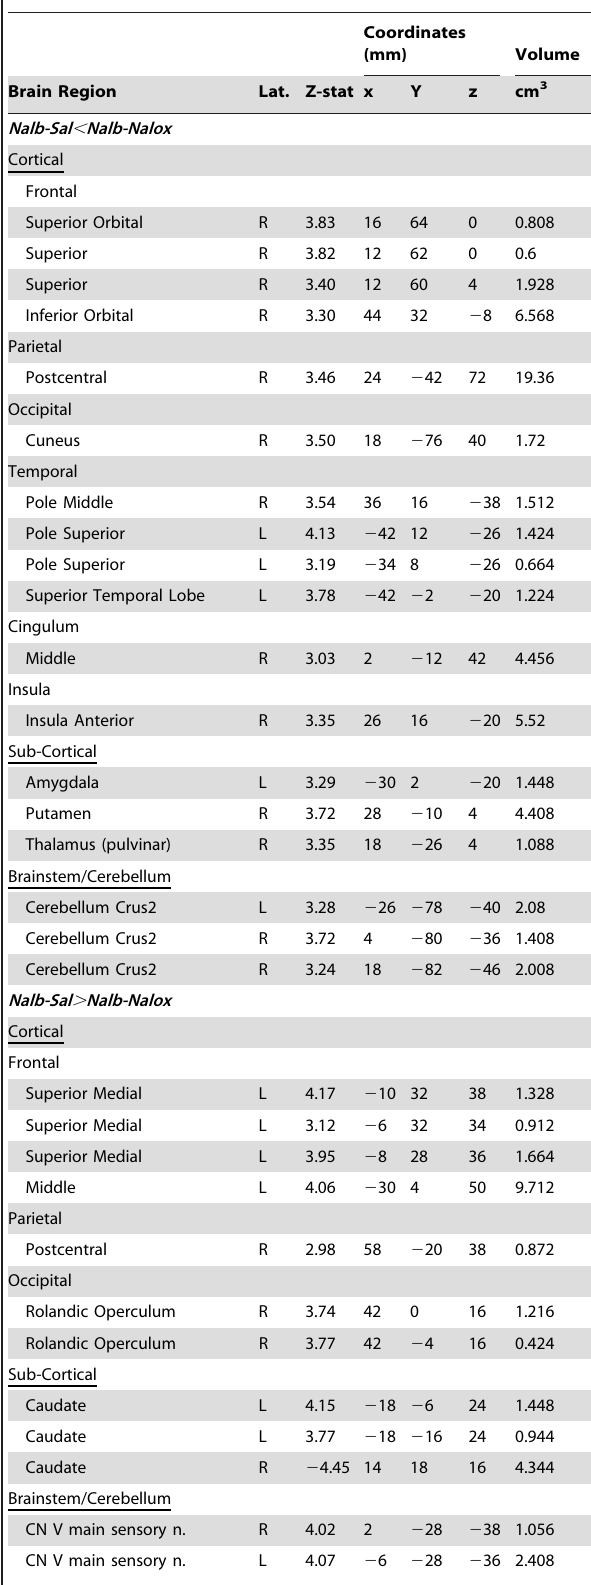
Coordinates (mm) Volume